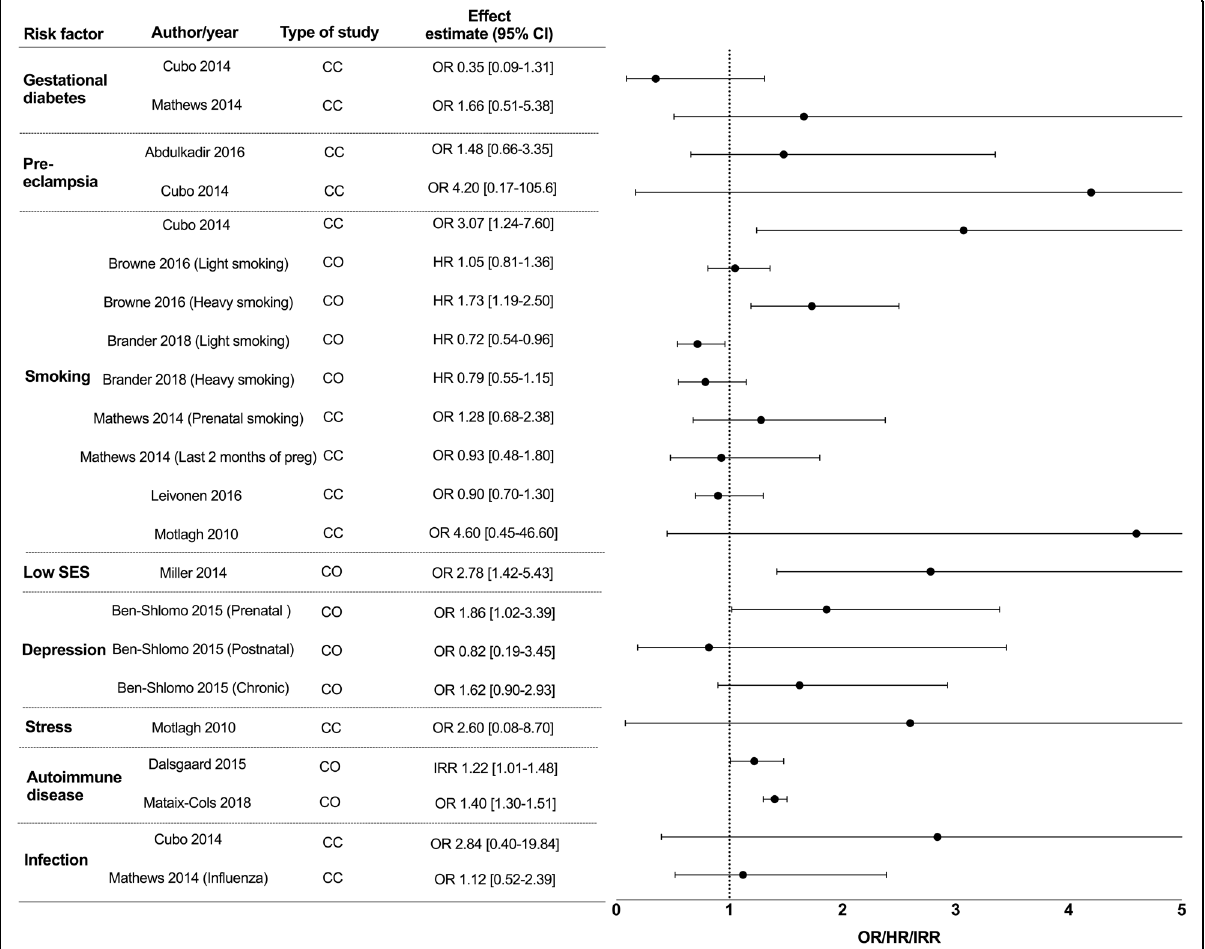
Fig. 5 Epidemiological studies of maternal in fl ammatory states and Tourette syndrome in offspring. Maternal in fl ammatory states included in Y-axis (with columns including author names, year of publication, type of study, number of individual studies included in meta-analysis, effect estimate with 95% con fi dence interval (CI)). Effect estimate with 95% con fi dence interval reported in X-axis. SES socioeconomic status, Preg pregnancy, CC case-control, CO cohort, RR relative risk, OR odds ratio, HR hazard ratio, IRR incidence risk